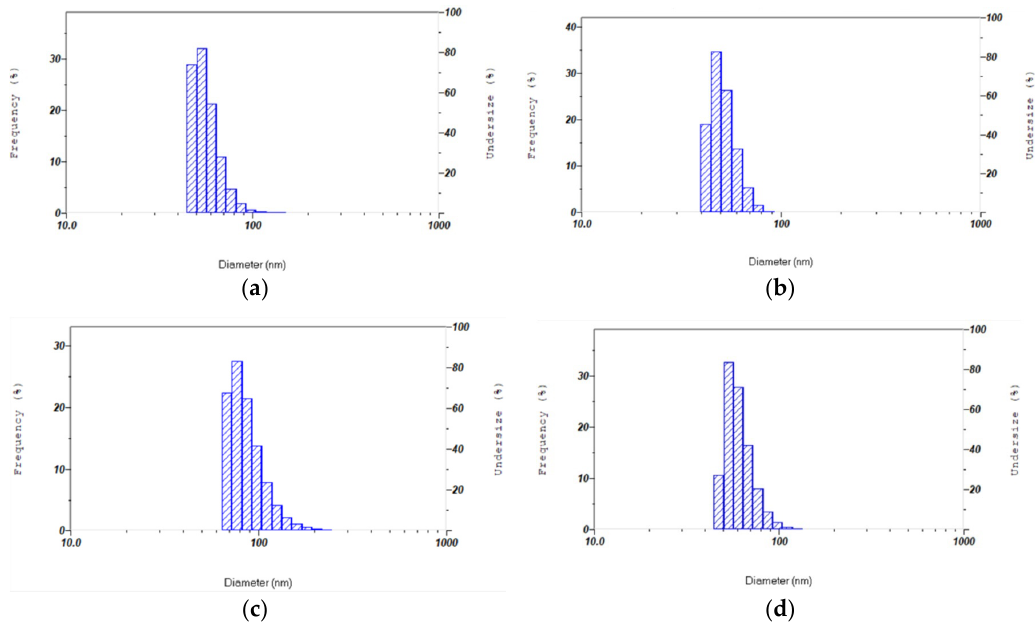
Figure 4. Dynamic light scattering (DLS) analysis of the four samples. From left to right: ( a ) TCA-AgNP; ( b ) TCA-AgNP-PI; ( c ) Cinn-AgNP; ( d ) Cinn-AgNP-PI.